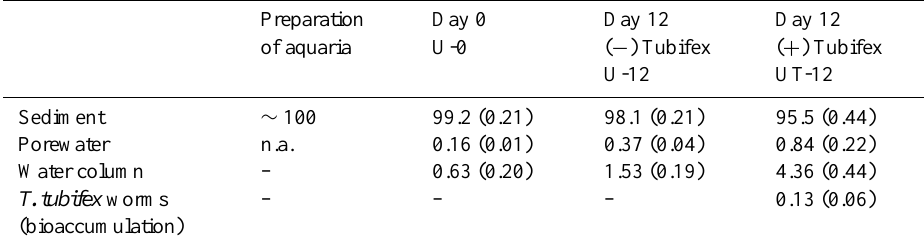
Table 1. Mass balance of U between the different compartments of the benthic ecosystem reproduced in mesocosms. Means in % (SD), N = 3. The data corresponding to control (i.e. uncontaminated) treatments – [C-O], [C-12] and [CT-12] – are not reported (sedi- ment/porewater/water column: concentrations below the detection limit; bioaccumulation: no